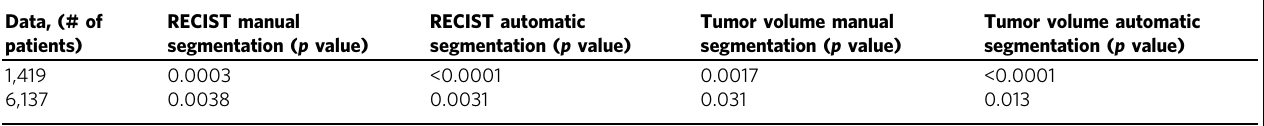
Statistical comparisons were performed using log-rank